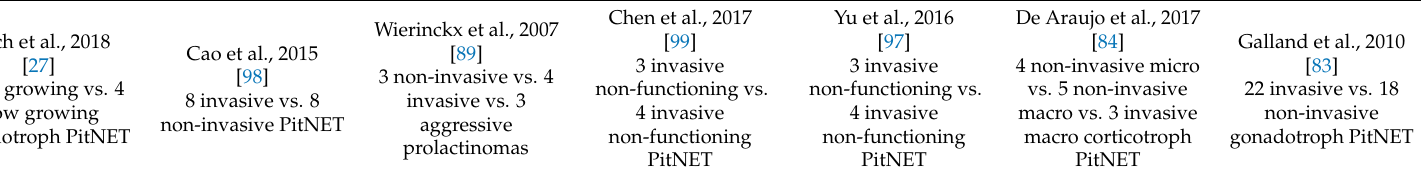
Table 1. Studies with overlapping candidate factors involved in PitNETs related to tumor growth and